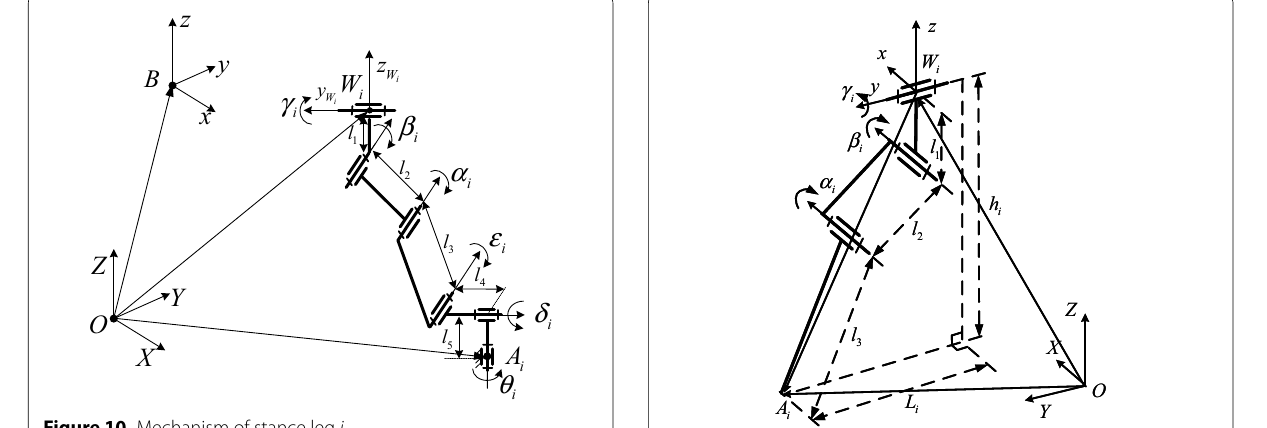
Figure 11 Mechanism sketch of leg i in